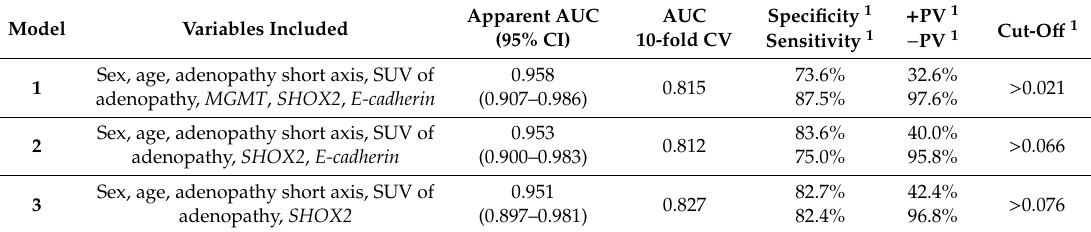
Table 5. Multivariate regression models for the detection of malignancy in cytological negative lymph nodes.